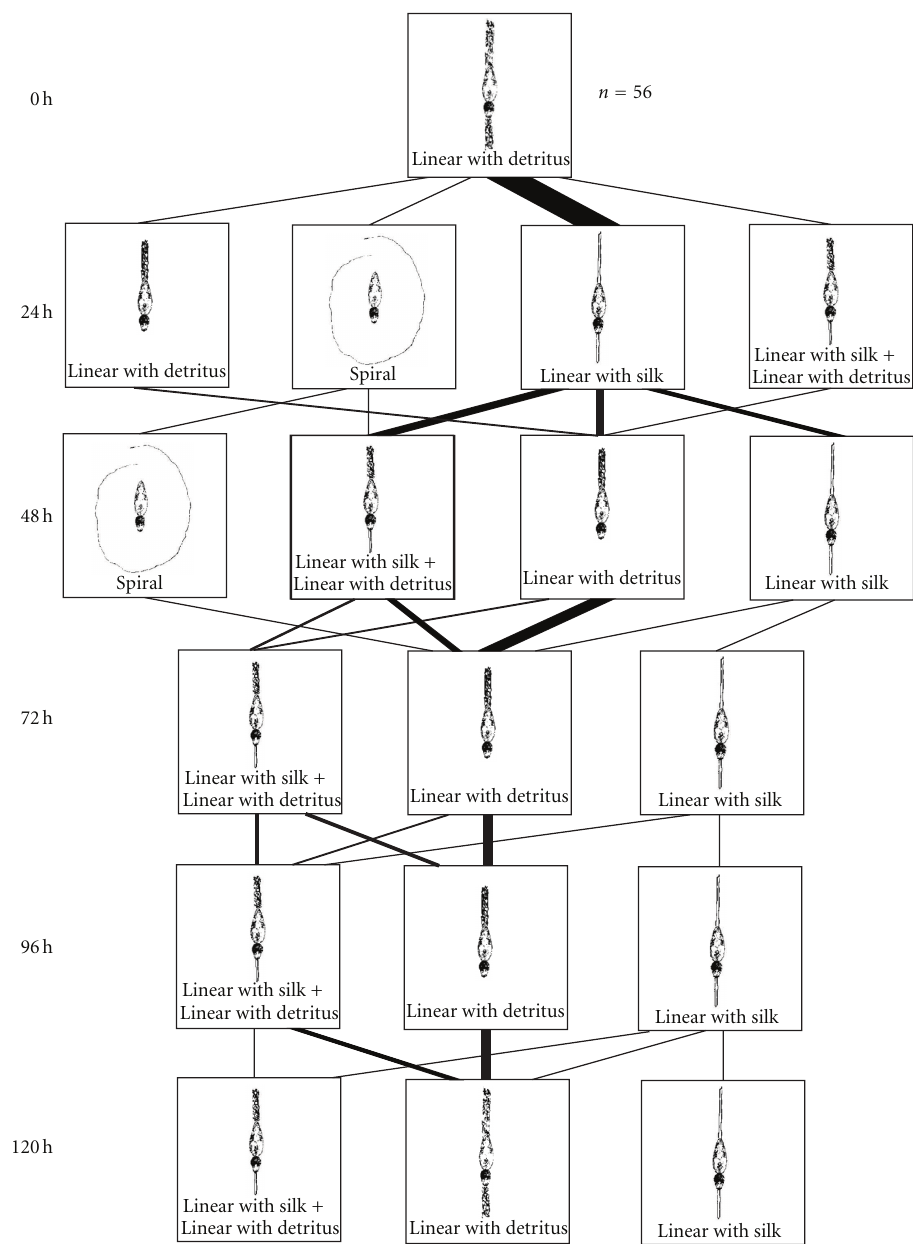
Figure 6: Reconstruction of stabilimenta by C. fililineata . The thickness of the lines indicates the number of webs that passed to the next